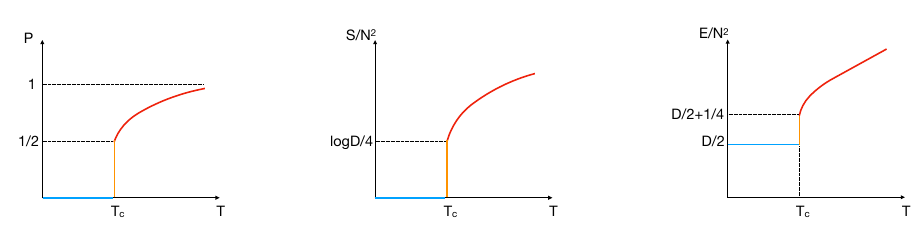
Figure 2 . Cartoon pictures of the temperature dependence of the Polyakov loop P , entropy S and energy E in the gauged Gaussian matrix model. Blue, orange and red lines are identi(cid:12)ed with the con(cid:12)ned, partially decon(cid:12)ned and completely decon(cid:12)ned phases,